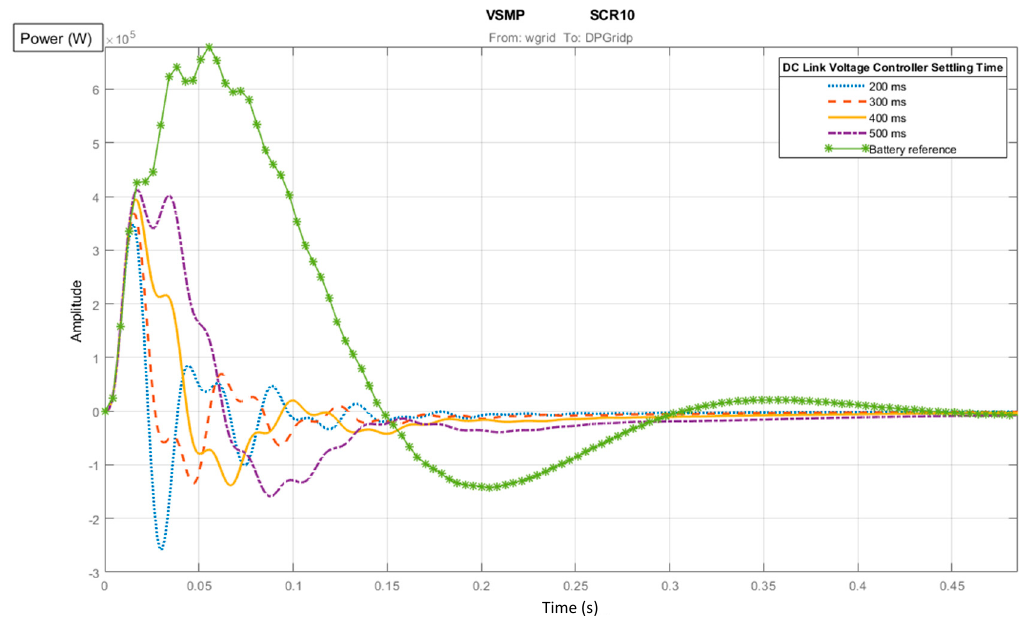
Time (s) Figure 20. Step response showing e ff ect of DC link controller bandwidth on VSM frequency Figure 20. Step response showing effect of DC link controller bandwidth on VSM frequency response.